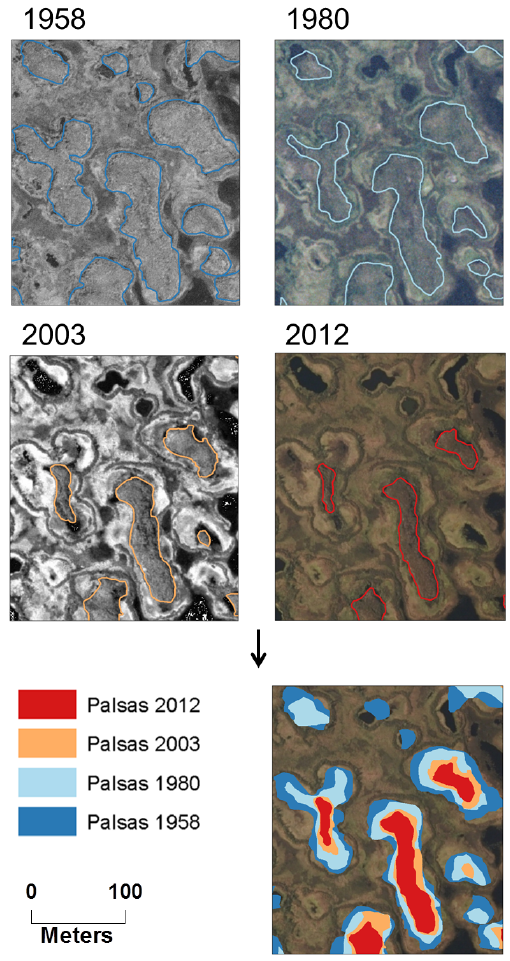
Figure 3. Example of polygons from the delineation of palsas at four different times in Goatheluoppal.